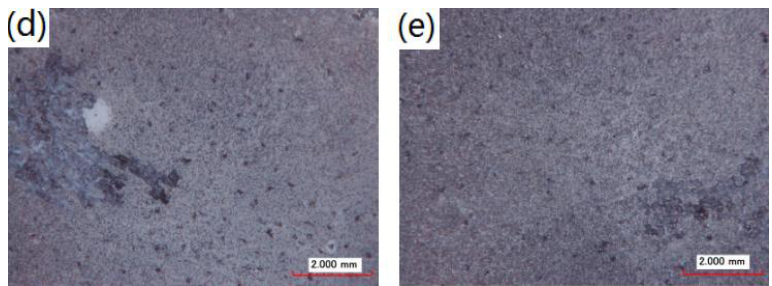
Figure 7. Macro-morphologies of the coated samples immersed in 3.5 wt % NaCl solutions for 12 days: